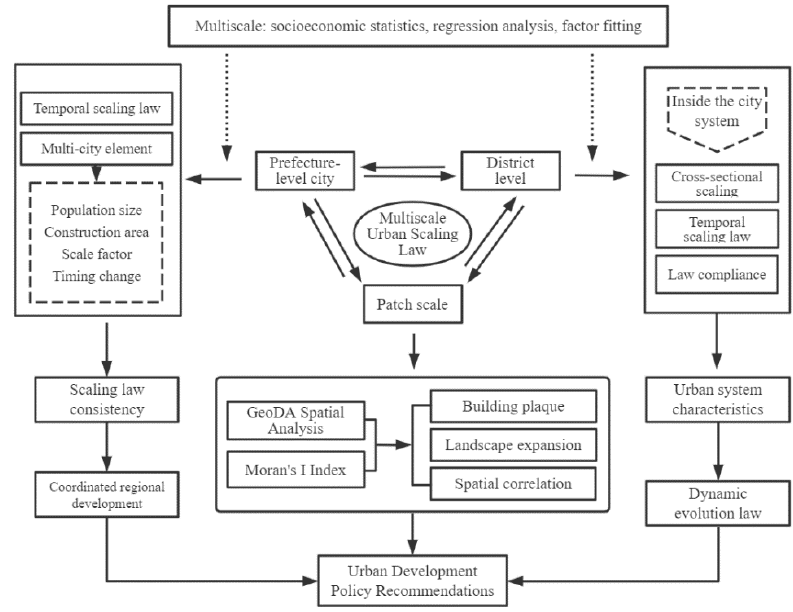
Figure 1. Flowchart of the study.